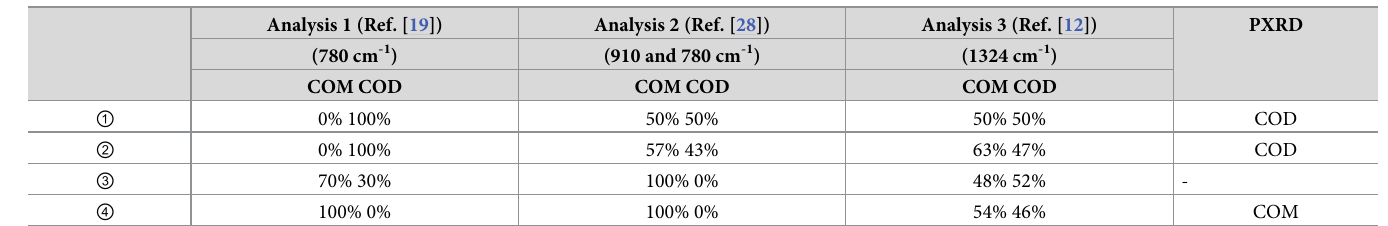
Table 1. The ratio of COM and COD calculated by the three different analyses. Analysis 1 (Ref.